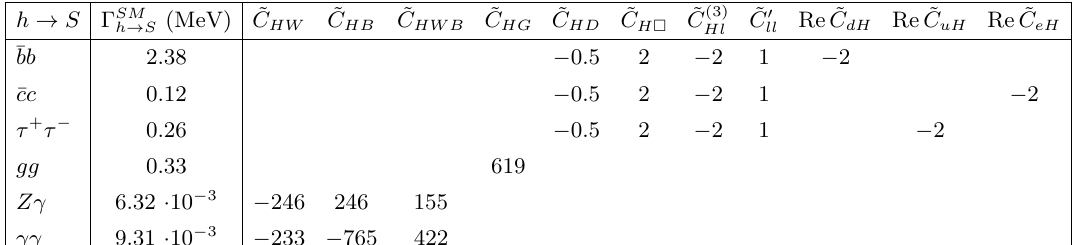
in the relative SMEFT correction i